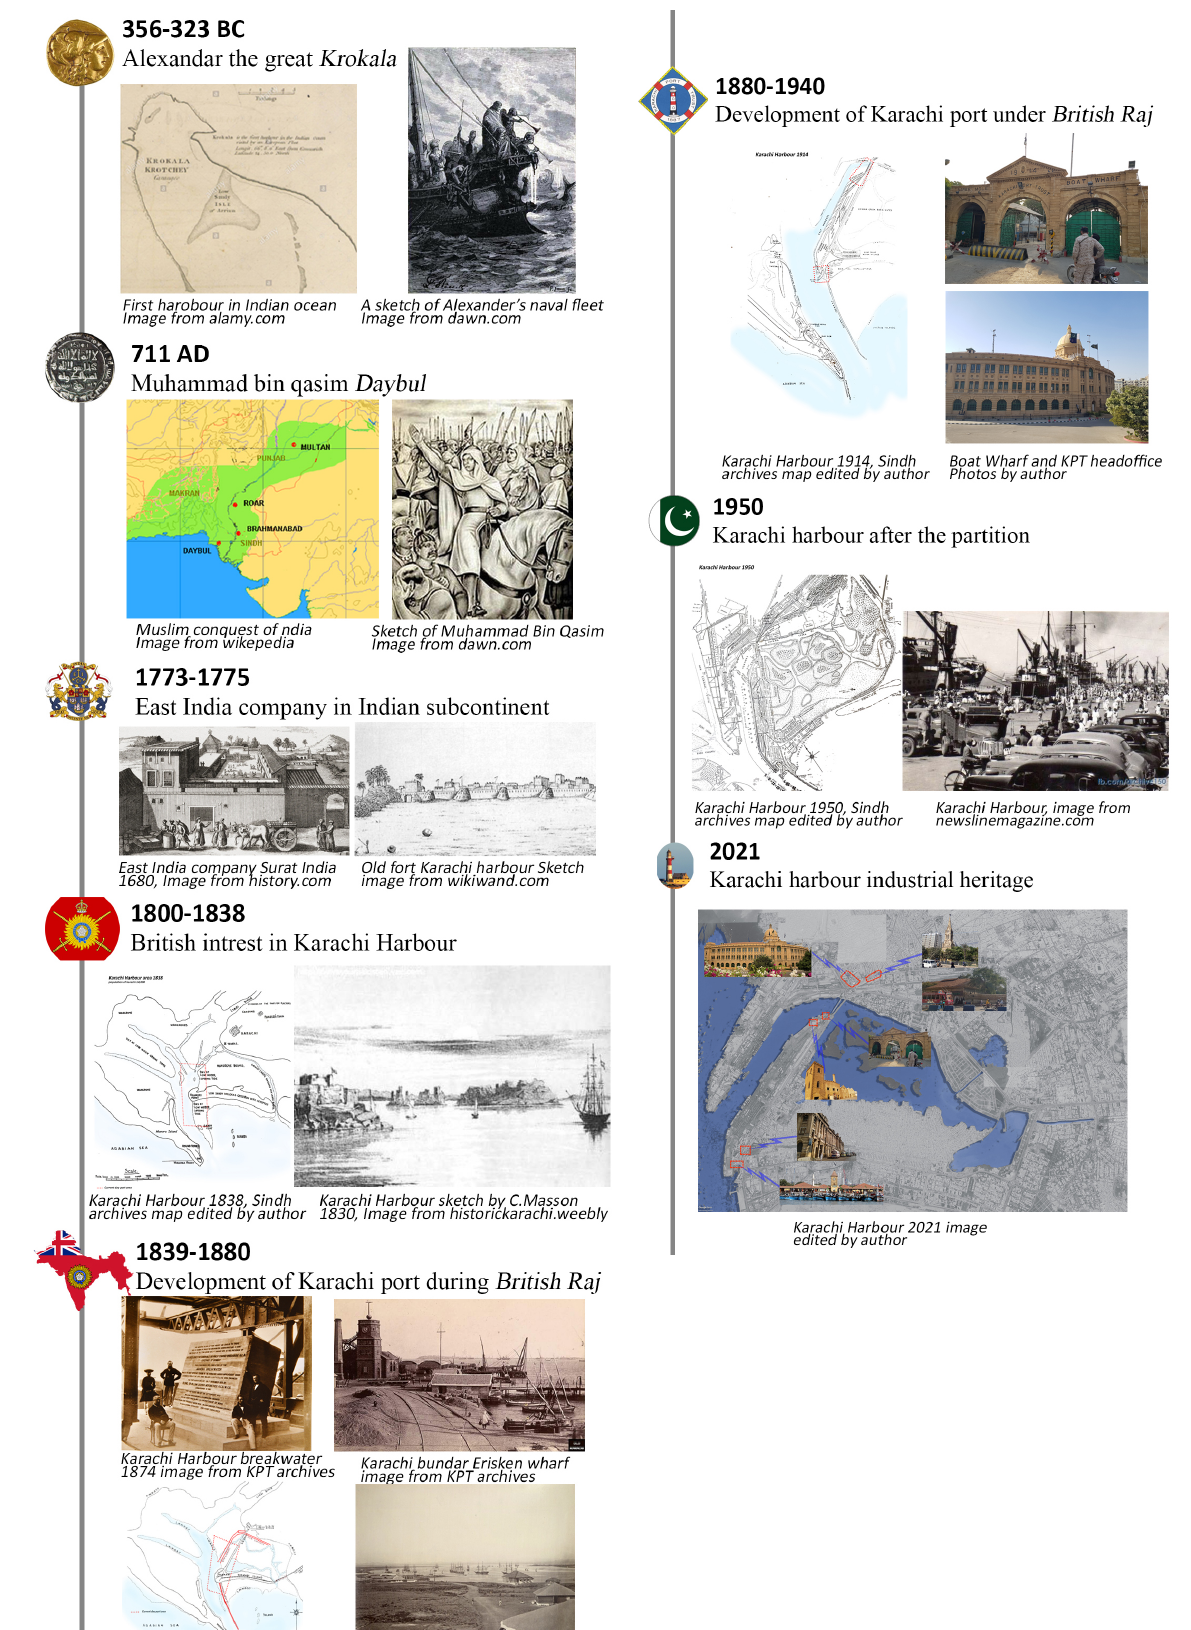
Figure 3. Historical timeline of Karachi